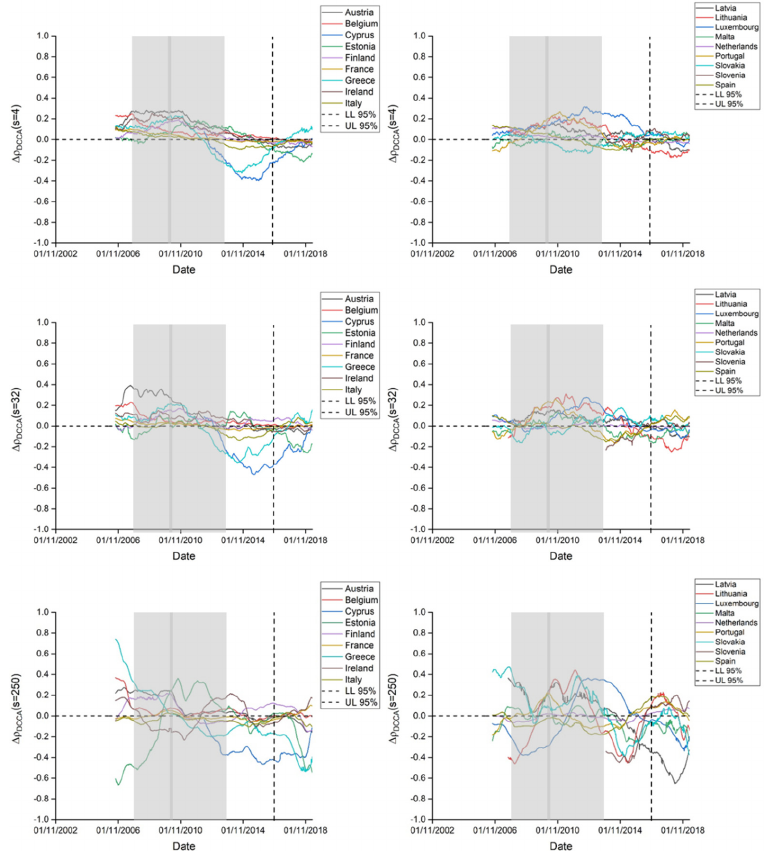
Figure 5. Evolution of the ∆ ρ DCCA between Eurozone stock markets and Germany for time scales of 4, 32, and 250 days, considering that ∆ ρ DCCA ( 1 ) = ρ DCCA ( 1001 ) − ρ DCCA ( 1 ) . LL and UL are, respectively, the lower and upper limits of the confidence interval. Shaded areas represent the global financial crisis and the Eurozone debt crisis. The vertical dashed line refers to the moment of the Brexit referendum.